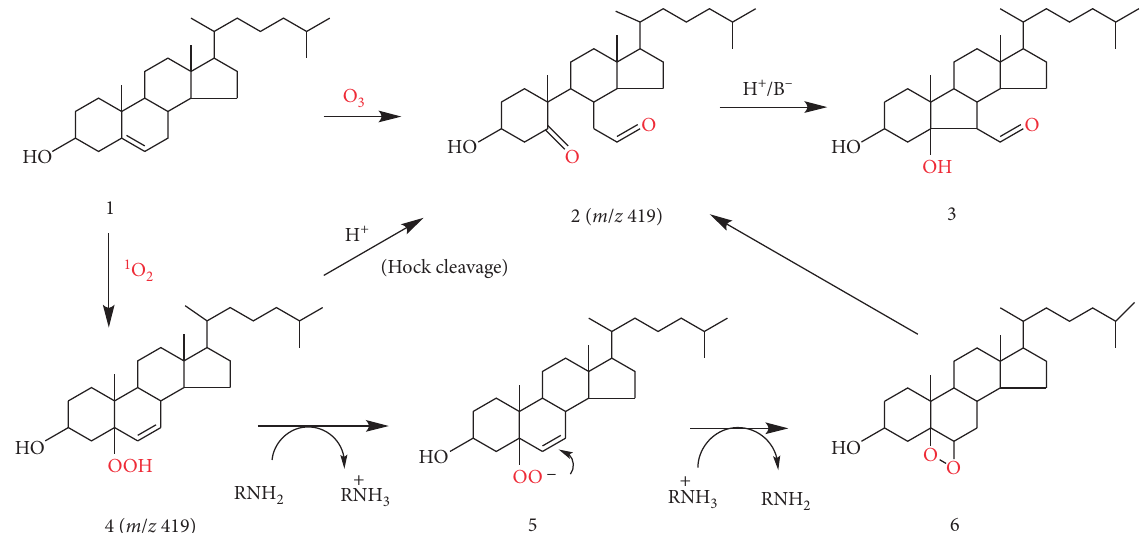
Scheme 1: Previously proposed pathways for formation of secosterol aldehydes 2 and 3 .